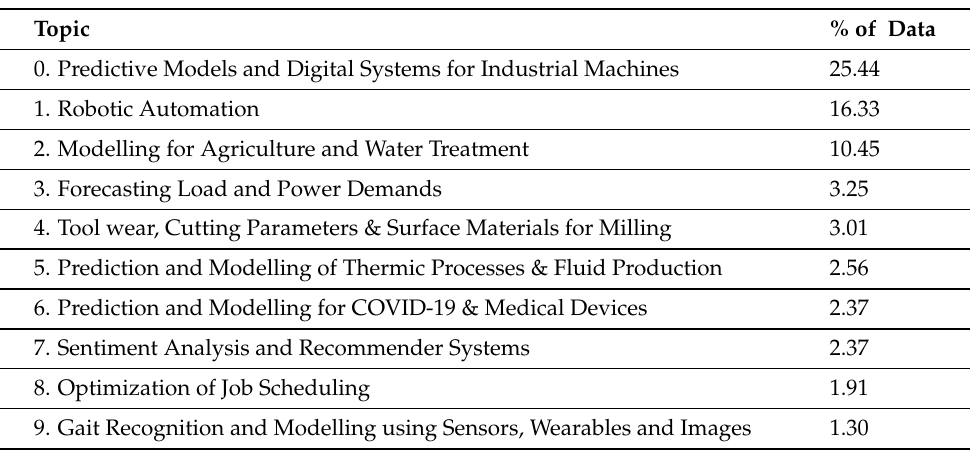
Table 2. Top 10 results of topic